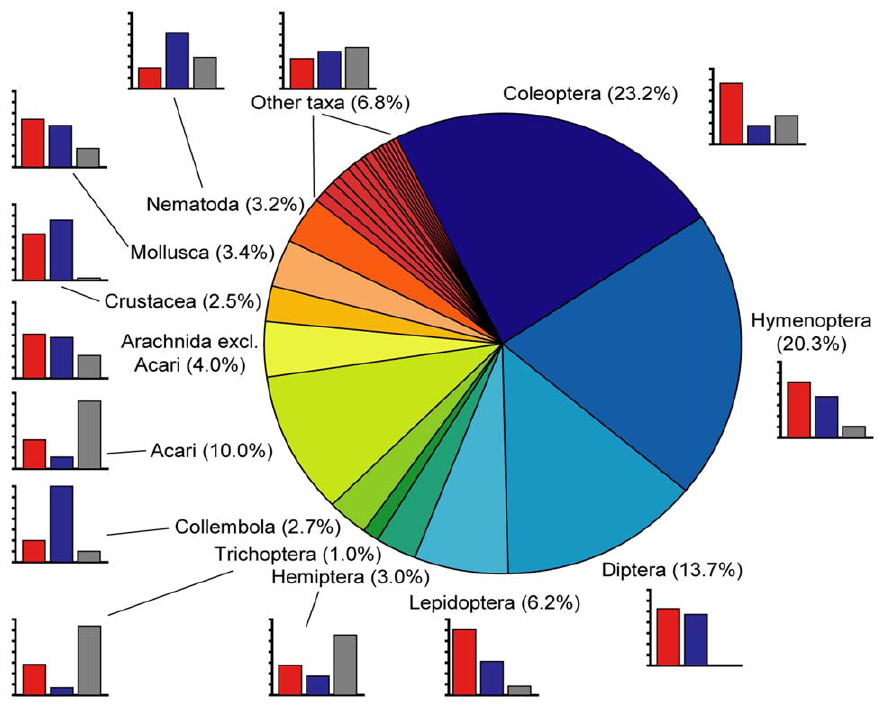
Figure 2. Current descriptions of new species in Europe. New species described from Europe in 1998–2007, expressed as percentages of the total of 5,881 species. Taxa representing less than 1% of the total are grouped. For each taxon, the percentages described by non-professional taxonomists (red), professional taxonomists (blue) and taxonomists whose status was unknown (grey) are indicated in histograms. Y-axis range on all histograms is 0–70%.